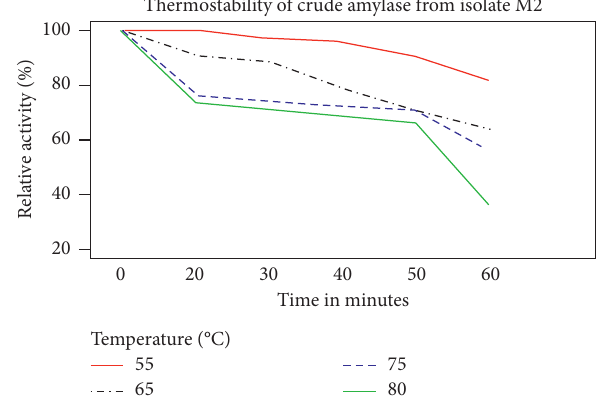
Figure 12: Thermostability of crude amylase from M2. Results are the average of the triplicate experiment.